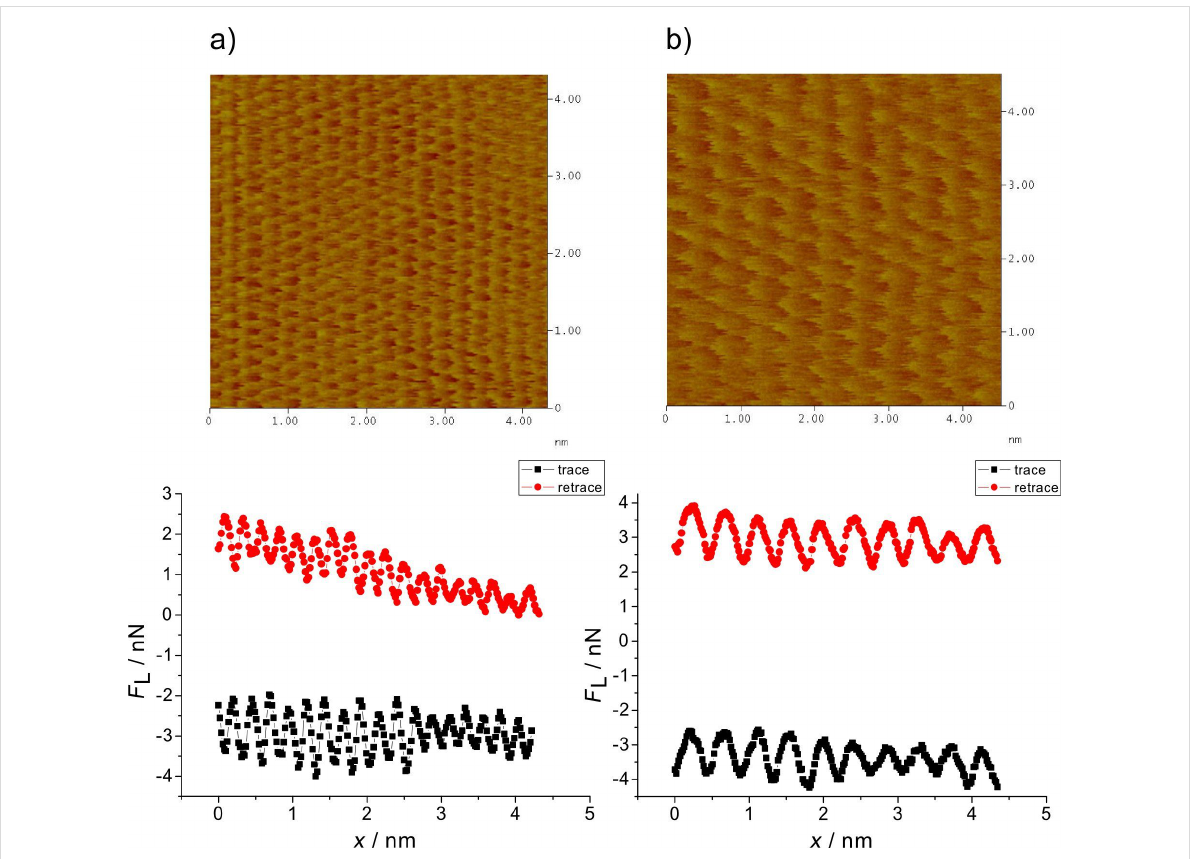
Figure 4: Stick–slip atomic resolution and cross section analysis for a) Au(111) at E = 270 mV; F N = 80 nN; scan rate 106 nm/s; b) Cu 2/3, E = 100 mV; F N = 45 nN; scan rate 92 nm/s.